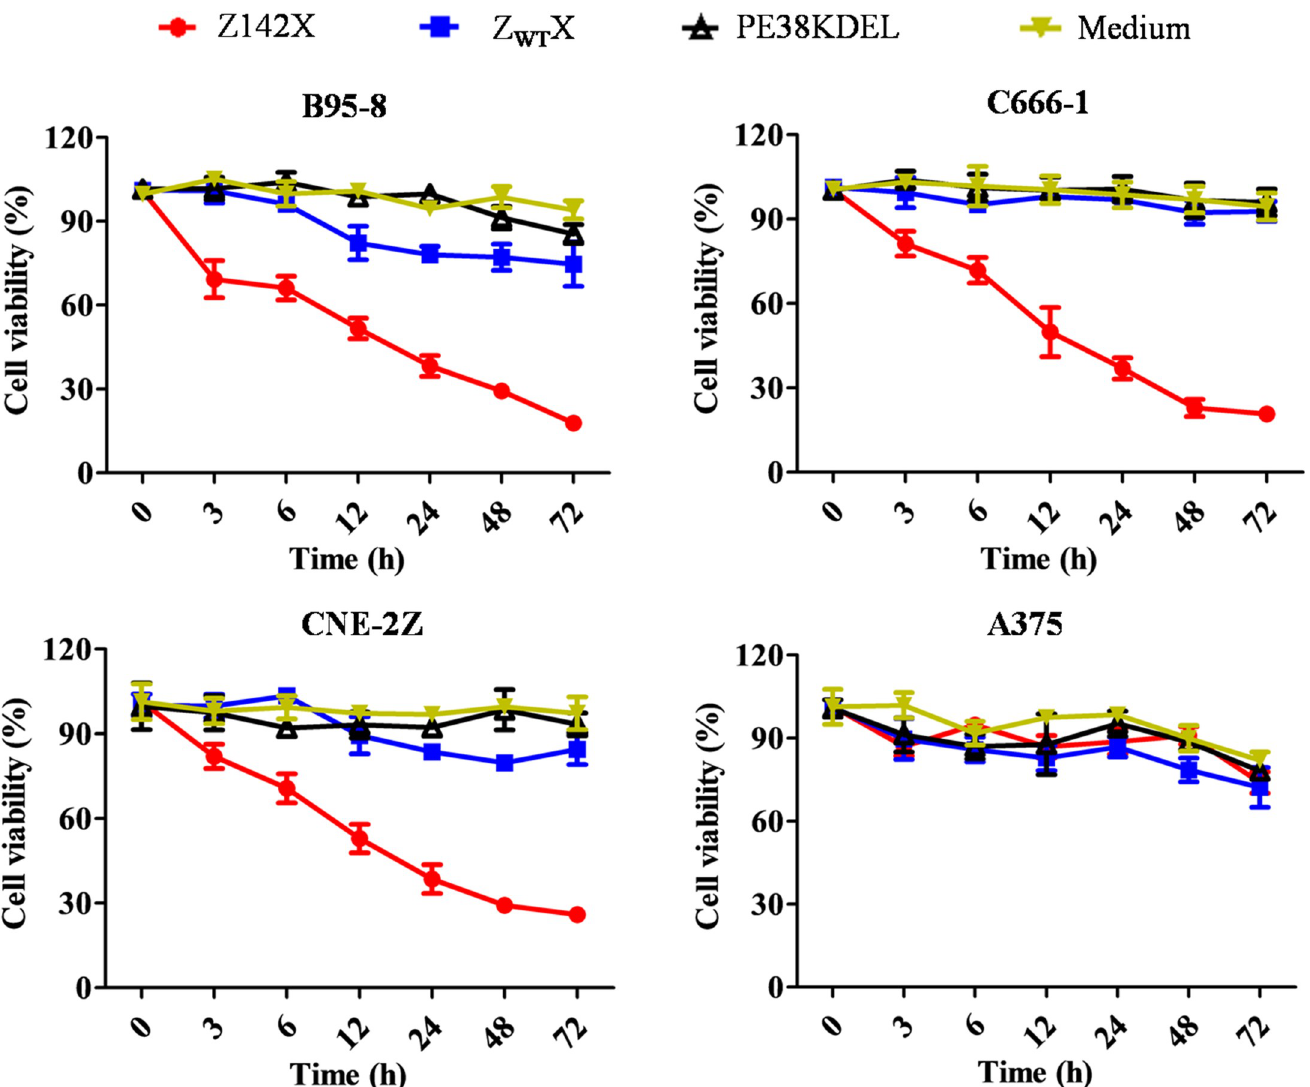
Fig 5. Z142X specifically kills EBV + cells in vitro . EBV + cells (B95-8, C666-1 and CNE-2Z) and EBV-negative cell (melanoma A375 cell) in 96-well plate were treated with 2.22 μ M of Z142X or control agents (Z WT X, PE38KDEL and medium) for the indicated time. Cell viability was assessed by using CCK-8 Kit. 2.22 μ M of Z142X reduced significantly the viability of EBV + cells (B95-8, C666-1 and CNE-2Z) during the indicated time periods, whereas A375 cells treated with the same concentration of Z142X remained fully viable. The control agents (Z WT X, PE38KDEL and medium) had no effect on any cell lines.